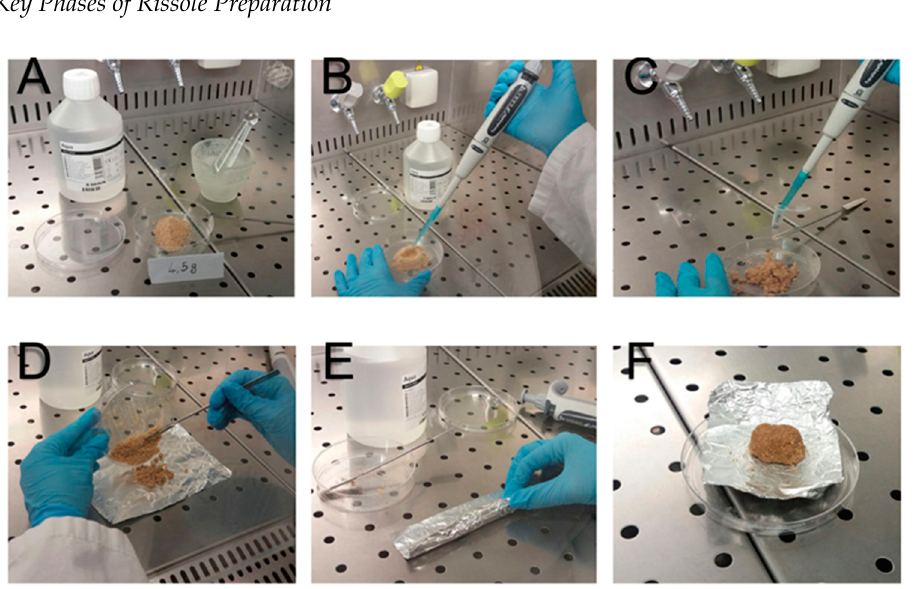
Figure A1. The rissoles were prepared in a sterile environment by pulverizing kibble food (Global Diet, Envigo plus) ( A ). Powder (4.5 g) of was mixed with 2.5 mL of sterile water ( B ) and 450 µl of BDNF